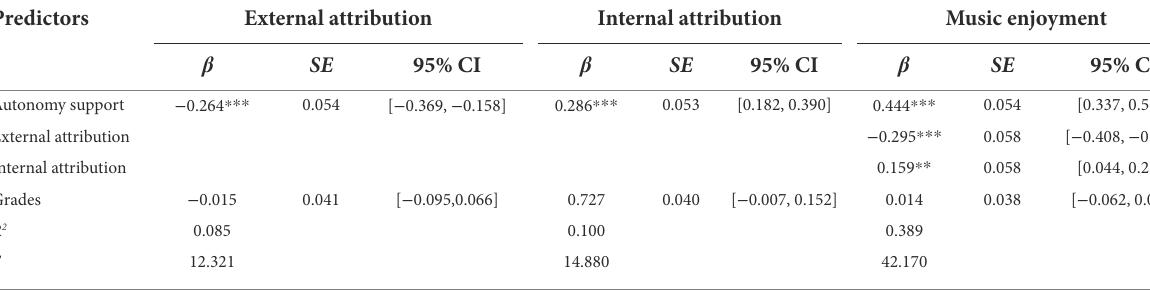
TABLE 2 Mediation model of attributions between autonomy support and music